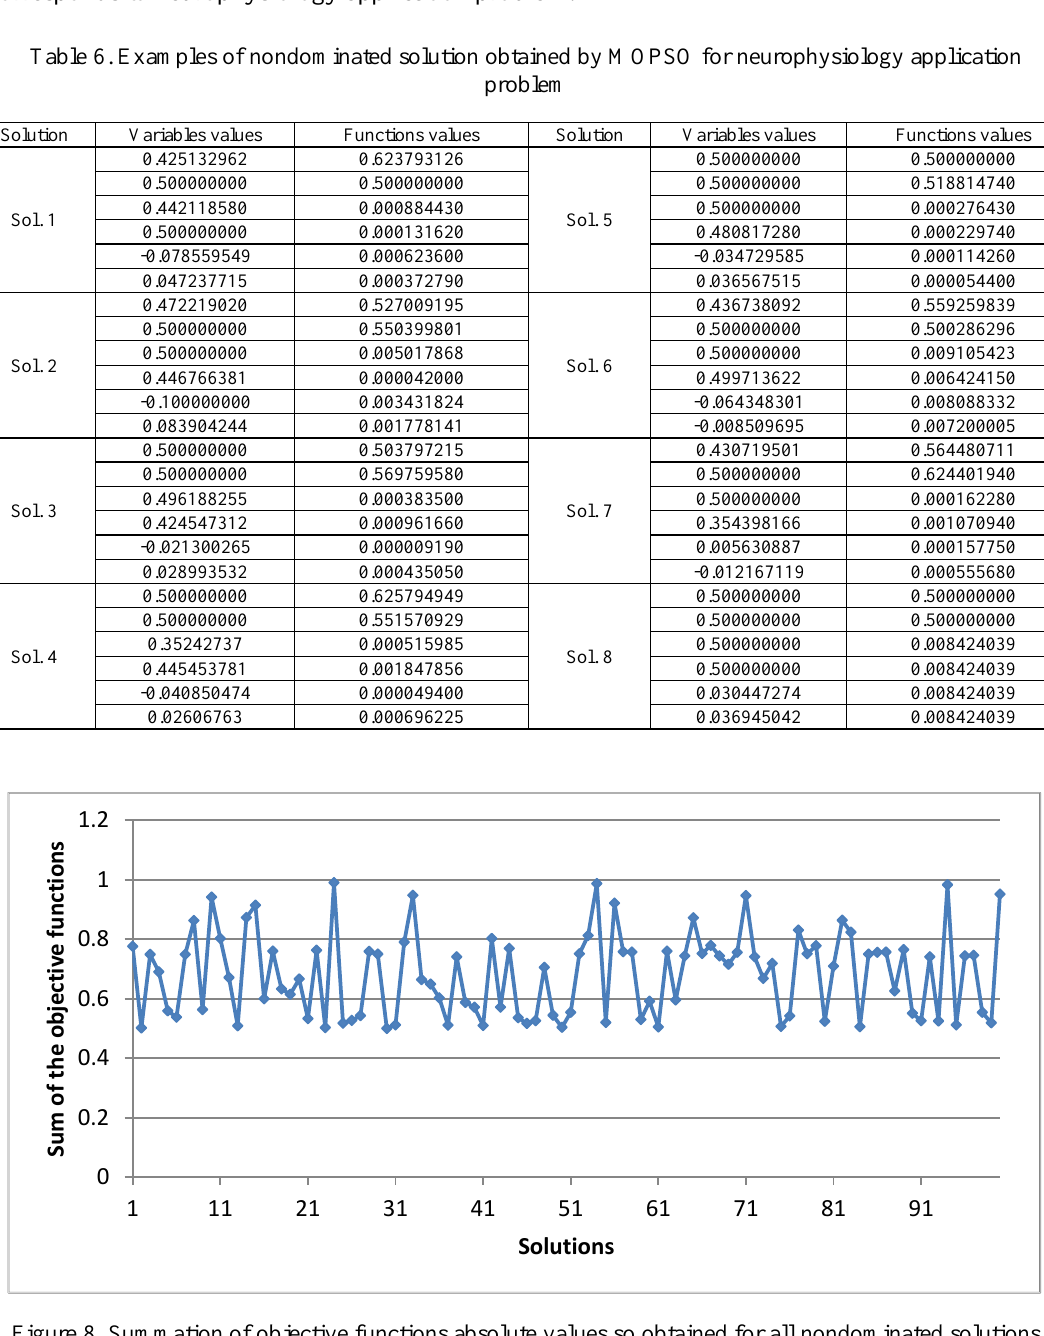
Figure 8. Summation of objective functions absolute values so obtained for all nondominated solutions corresponds to neurophysiology application